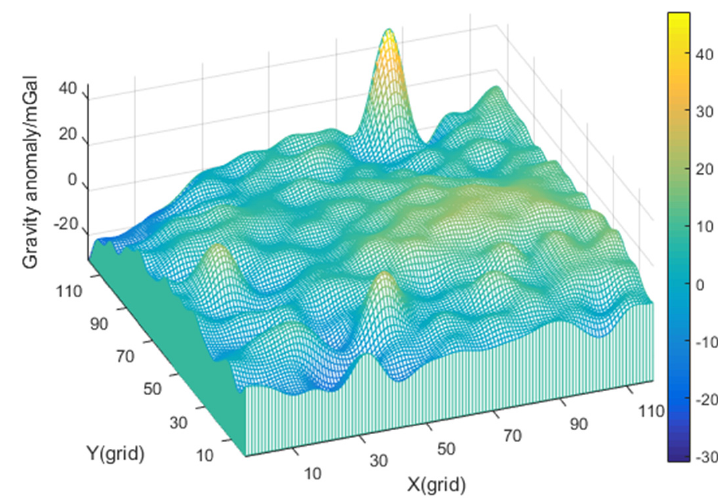
Figure 9. The distribution of gravity field of track 3. Table 5. Information of the sailing track 3.